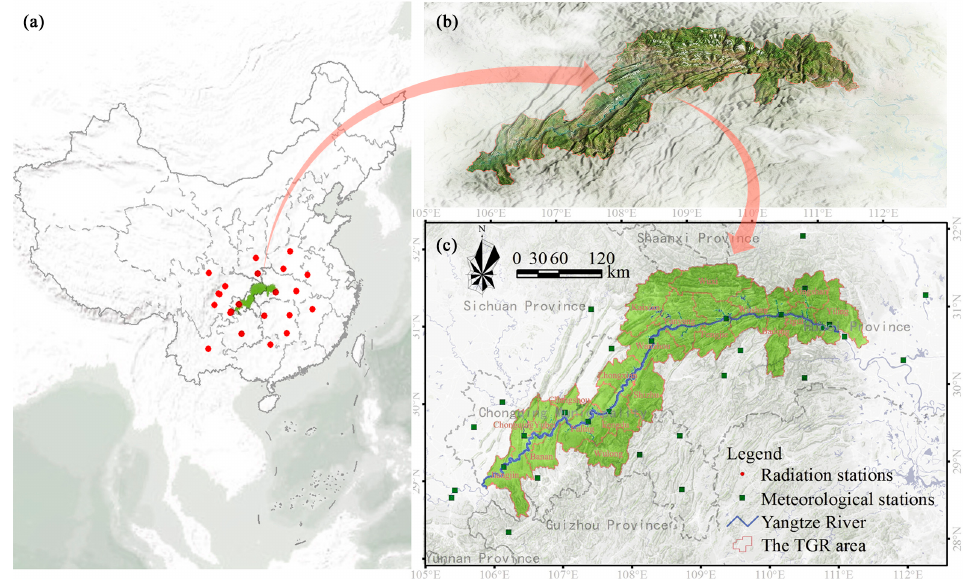
Figure 1. Locations of the radiation stations ( a ), the topographical characters of the Three Gorges Reservoir (TGR) area ( b ) and the meteorological stations of the precipitation and temperature data ( c ).